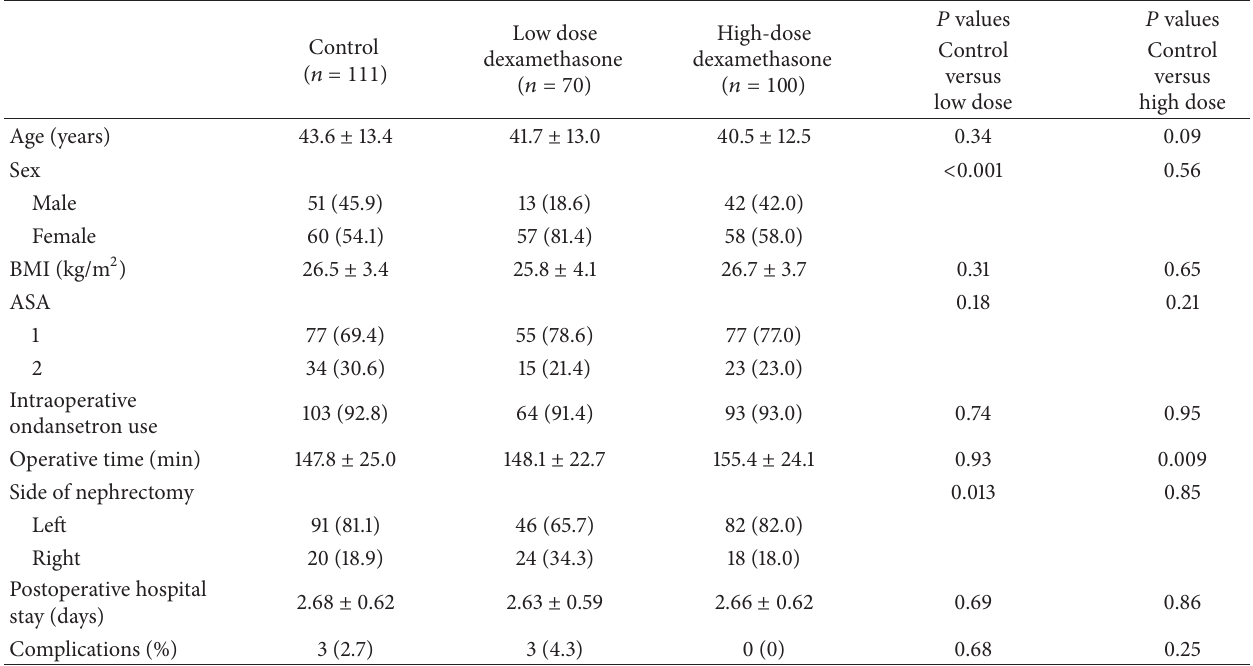
Table 1: Donor baseline variables and surgical outcomes.